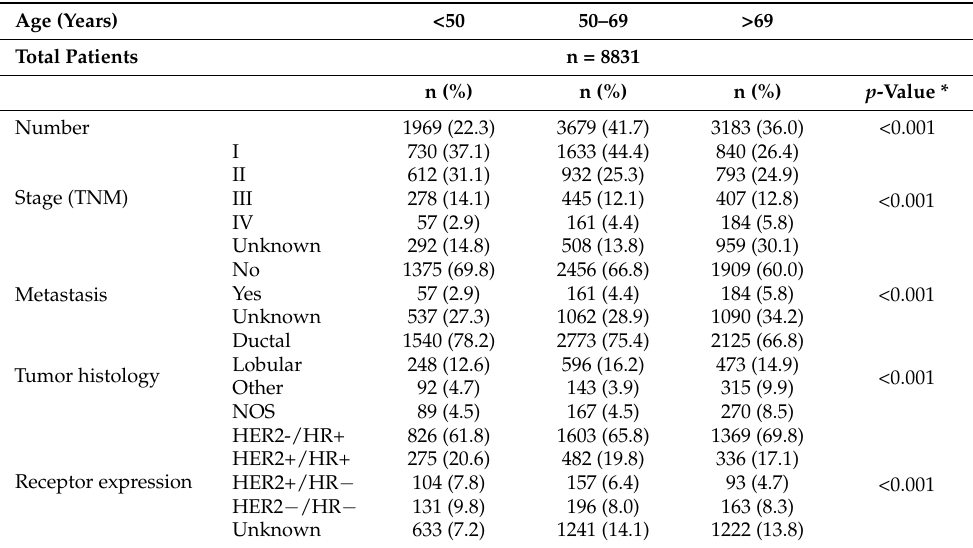
Table 1. Characteristics of breast cancer patients according to age